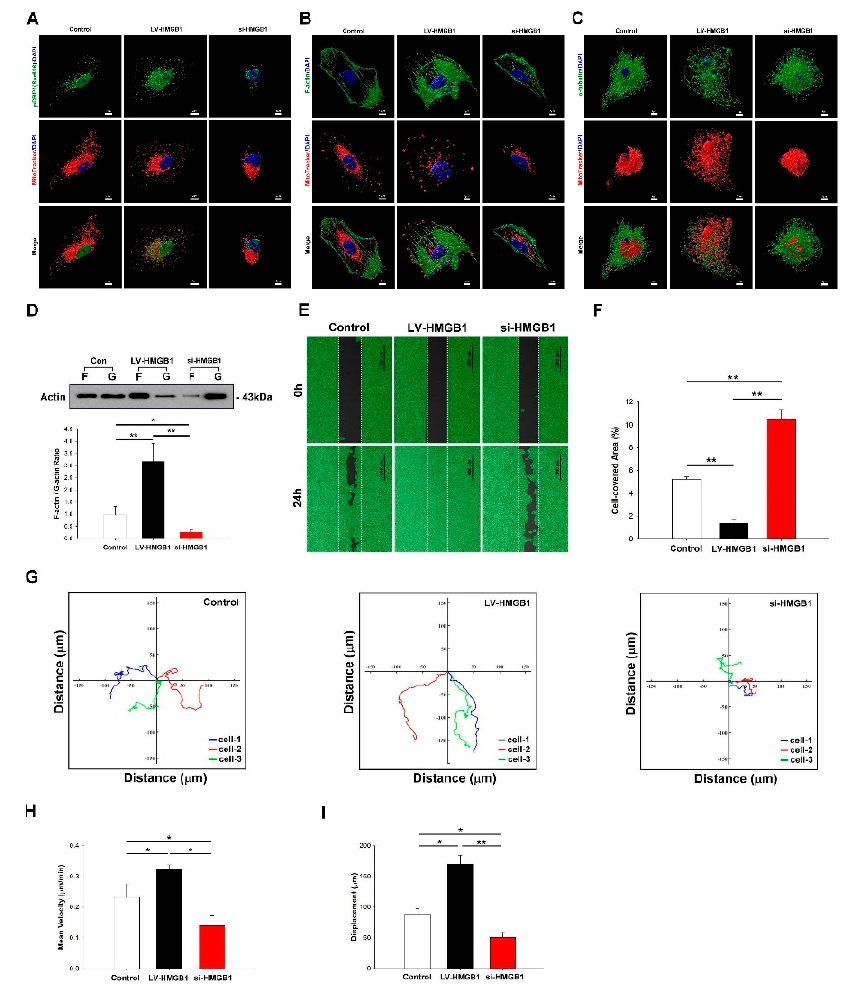
Figure 3. HMGB1 regulates DRP1 phosphorylation and mediates mitochondrial trafficking from the cortical cytoskeleton to the leading edge to promote cancer migration. ( A ) A549 cells were transfected with LV-HMGB1 or si-HMGB1 for 48 h. Cells were stained with HMGB1 (green color), phospho-DRP1 (pDRP1) (Ser616) (red color), and nucleus dye (blue color), and they were analyzed using confocal microscopy and the Imaris software. ( B , C ) Mitochondrial repositioning (mitochondria tracker dye: red color) and F-actin/ α -tubulin (green color) expression, respectively, were analyzed using confocal microscopy and the Imaris software. ( D ) F-actin and G-actin expressions were analyzed by Western blot (WB). ( E , F ) Cell migration was analyzed using the wound-healing assay (scale bar: 500 µ m). Cells were analyzed by time-lapse microscopy. ( G ) migration distance, ( H ) mean velocity, and ( I ) displacement were determined. * p < 0.05 and ** p < 0.01 compared with the control. F: F-actin; G: G-actin.